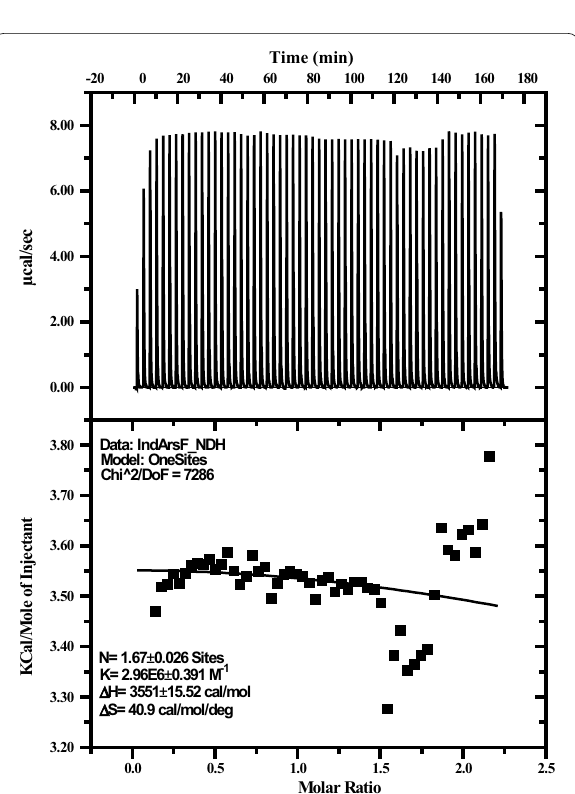
Fig. 5 ITC data for binding isotherm for interaction between In and ARS at 298 K (normalization was done with heats per peak as a function of molar ratio in the calorimetric cell )